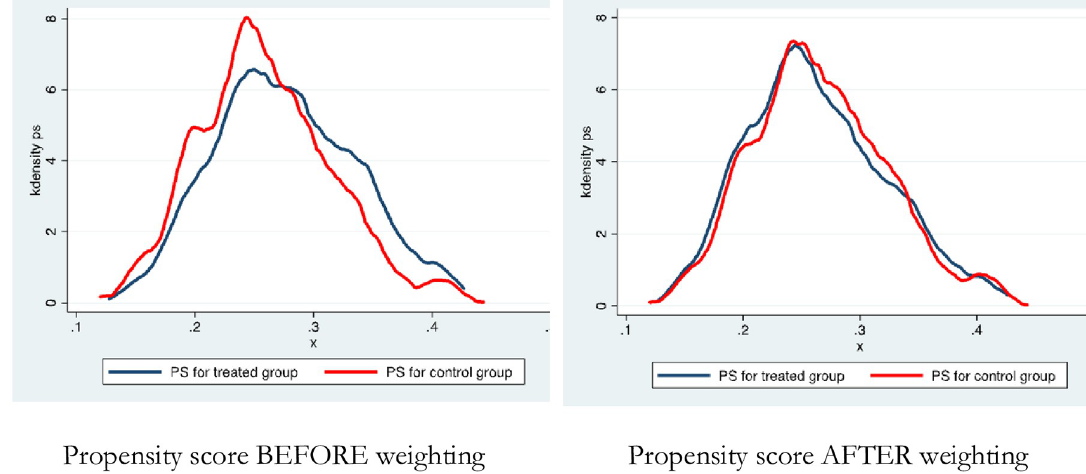
Fig 2. Balance of propensity scores (PS) before and after weighting across treatment and comparison groups.